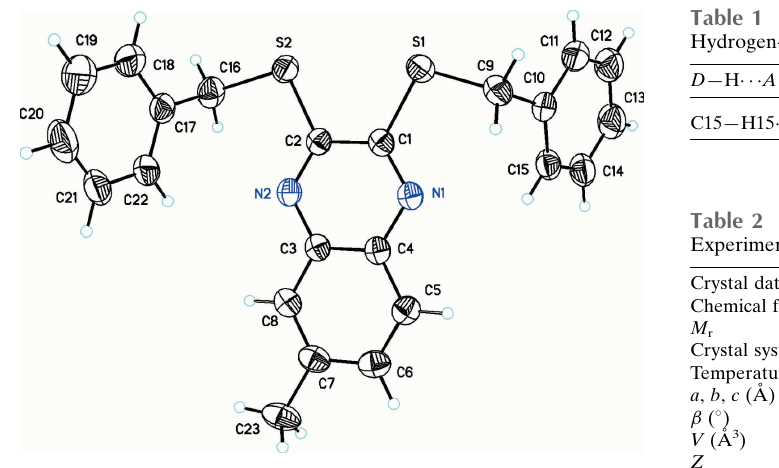
Figure 1 The molecular structure of the title compound showing 30% probability displacement ellipsoids. Atom C23, [0.531 (7) occupancy] methyl group is shown bonded to C7, whereas minor occupancy atom C23 A , [0.469 (7) occupancy] has been omitted for clarity. Only atoms C9—C15 [occupancy 0.649 (7)] of the disordered phenyl ring of the the benzylthio ring system are shown for